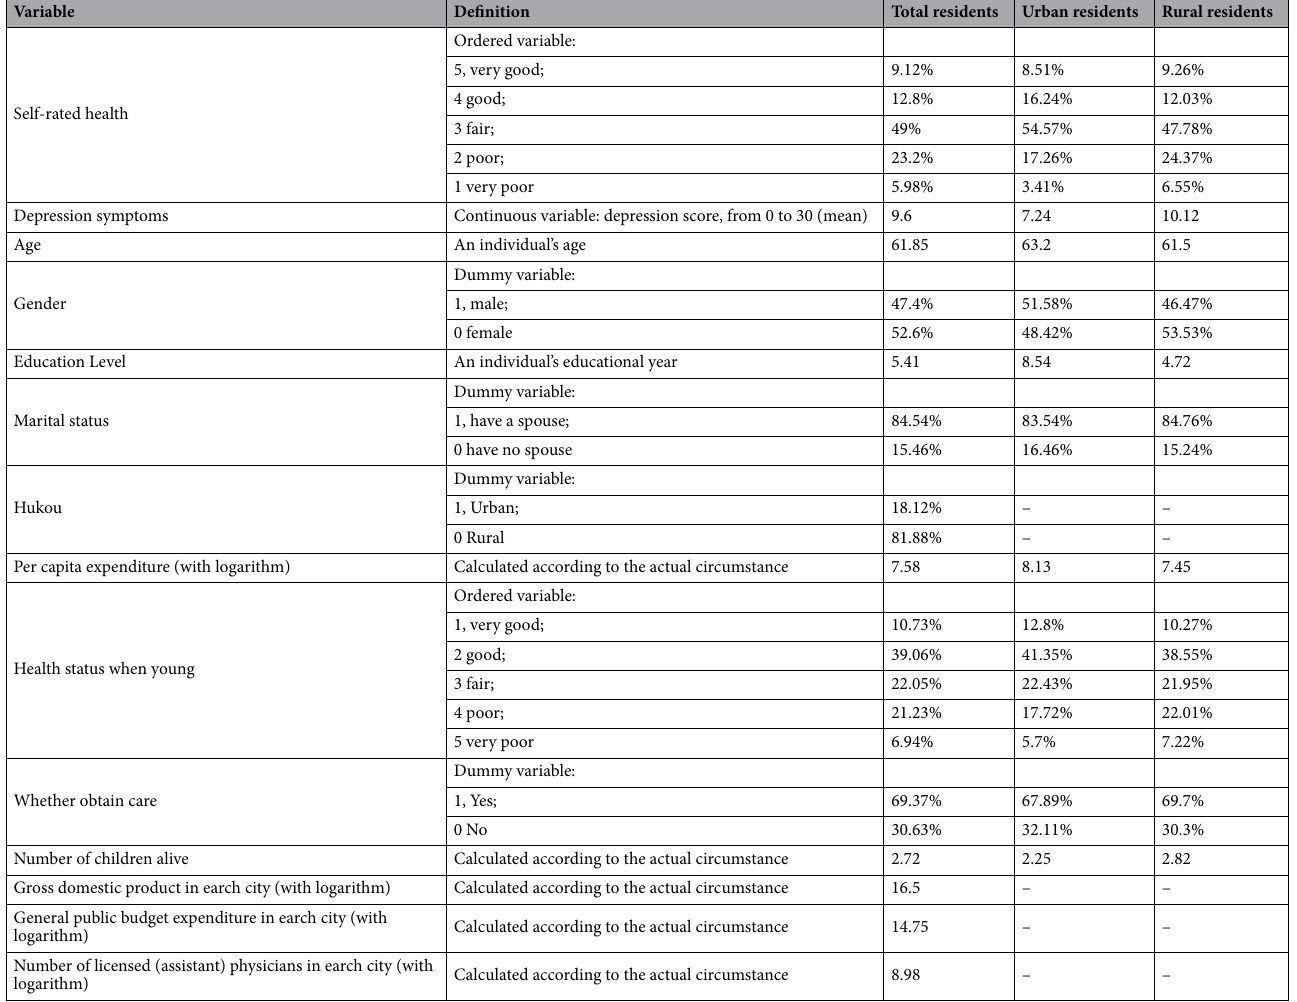
Table 2. Descriptive statistics of variables. Mean were performed for continuous variables. N (%) were performed for categorical